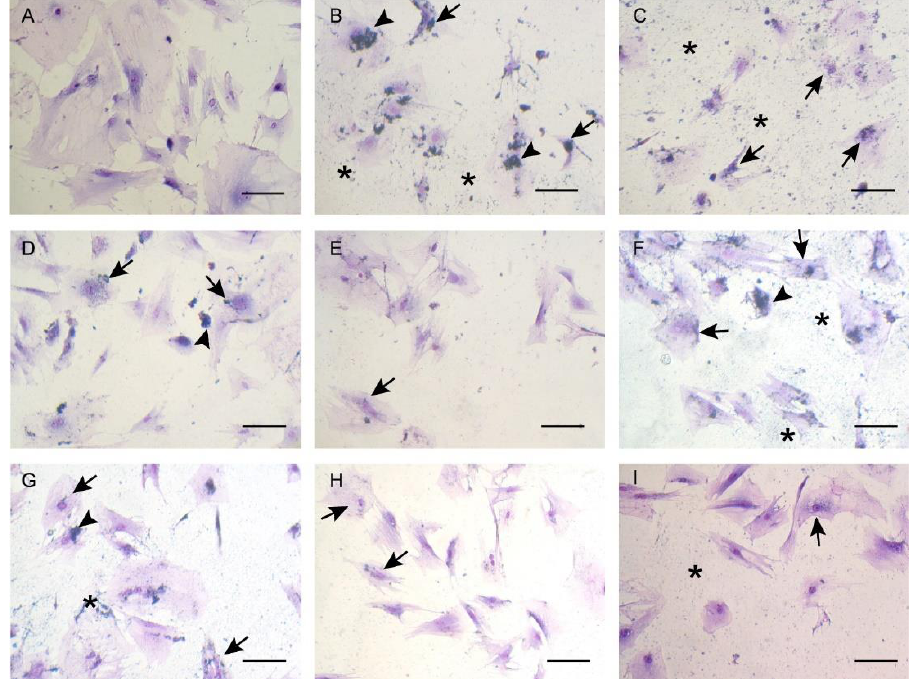
Figure 6. Incubation of Adipose-derived stromal cells (ASCs) with Laser ablated Albumin function- alized AuNPs (LA-AuNPs) for 24 h resulted in fine dispersion of particles on well surface (asterisk), LA-AuNPs intracellular uptake (arrow), and clusters on cell surface (arrowhead). Control without LA-AuNPs ( A ), cells exposed to 2 nm LA-AuNPs ( B – E ), and 53 nm LA-AuNPs ( F – I ), in the dilutions 1:1 ( B , F ), 1:2 ( C , G ), 1:5 ( D , H ), and 1:10 ( E , I ). Giemsa staining, objective 20x, scale bars 100 µm.